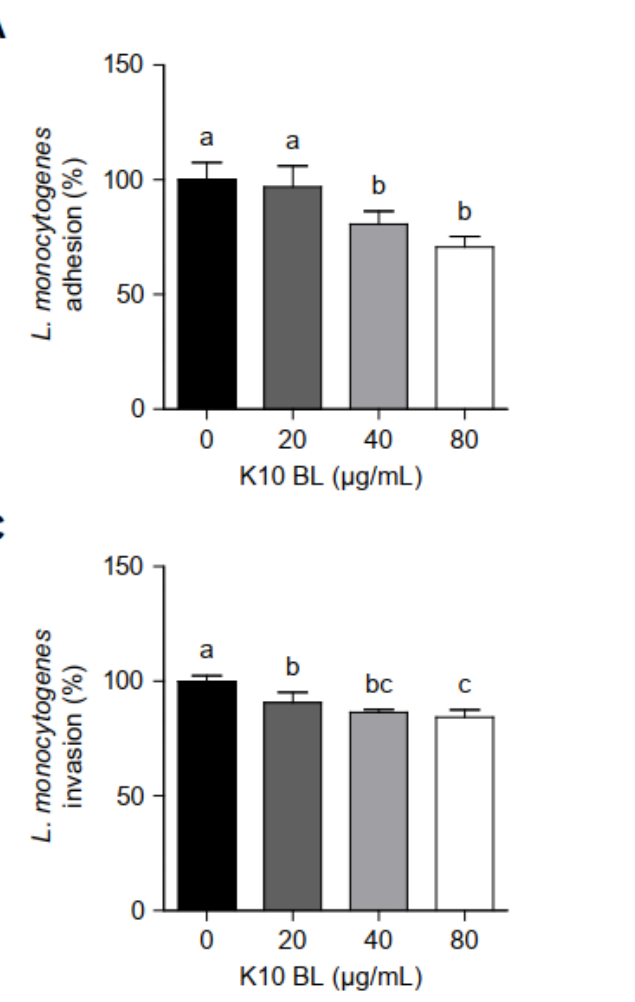
Figure 5. L. monocytogenes adhesion to and invasion of HT-29 cells in the presence or absence of P. acidilactici BLs. HT-29 cells were pretreated with K10 BL ( A , C ) or HW01 BL ( B , D ) (0, 20, 40, and 80 μ g/mL) for 3 h, after which L. monocytogenes (1 × 10 7 CFU/mL) was added and incubated for 1 h. Adhesive and invasive abilities of L. monocytogenes were determined by plating samples on BHI agar. The results are represented as the means ± standard deviations from three independent experiments ( p < 0.05). Significant differences between treatment with K10 BL or HW01 BL are expressed with different letters (a-d).